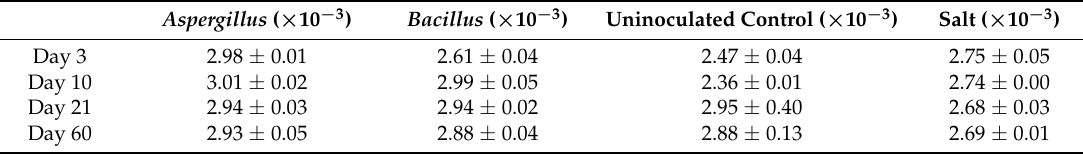
Table 5. Lu to La ratio. Errors are plus and minus one standard deviation from triplicate leaching